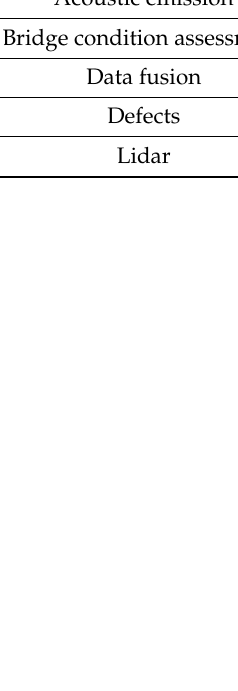
Table 6. Summary of the most influential articles in CBD_NDT